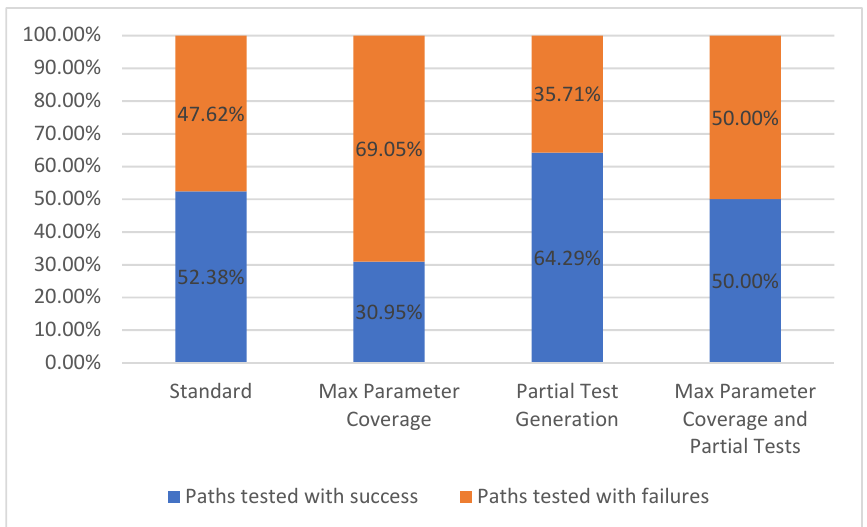
Figure 9. Paths tested.